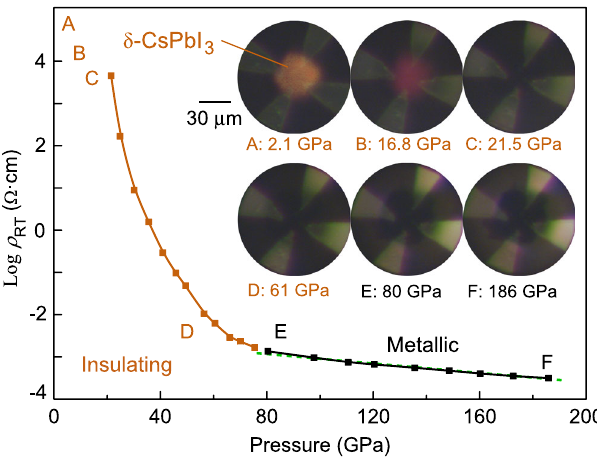
Fig. 1 | Room-temperature resistivity (Log ρ RT ) of CsPbI 3 as a function of pressure. Theorangeandblacksquaresrepresentthedatafromtheinsulatingand metallic phases, respectively. The green dashed line is a linear fi t of the log ρ RT – P curve above 80GPa. A slope of − (5.3±0.4)×10 − 3 Ω ·cm/GPa is obtained. The pho- tomicrographs show the hand-wired electrode con fi guration for the high-pressure resistivity measurements and the color change of the sample from yellow to red and further to opaque black under